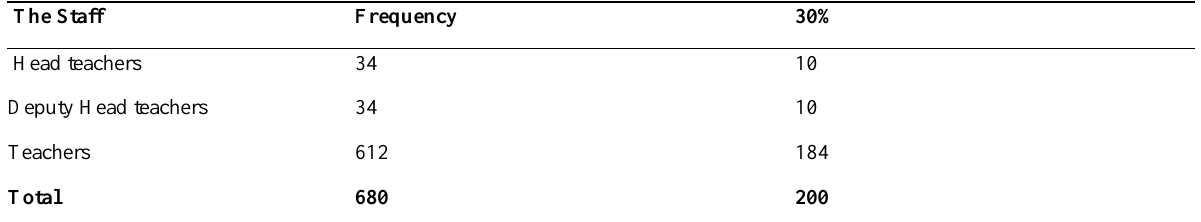
Table 1: Sample Size of 30% of Target Population